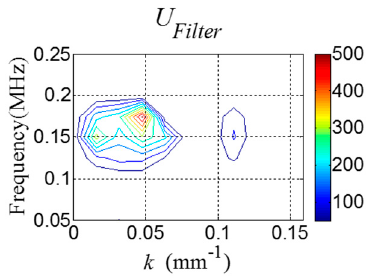
Figure 16. f-k domain plot of (cid:1847) (cid:3007)(cid:3036)(cid:3039)(cid:3047)(cid:3032)(cid:3045) computed from Figure 14.